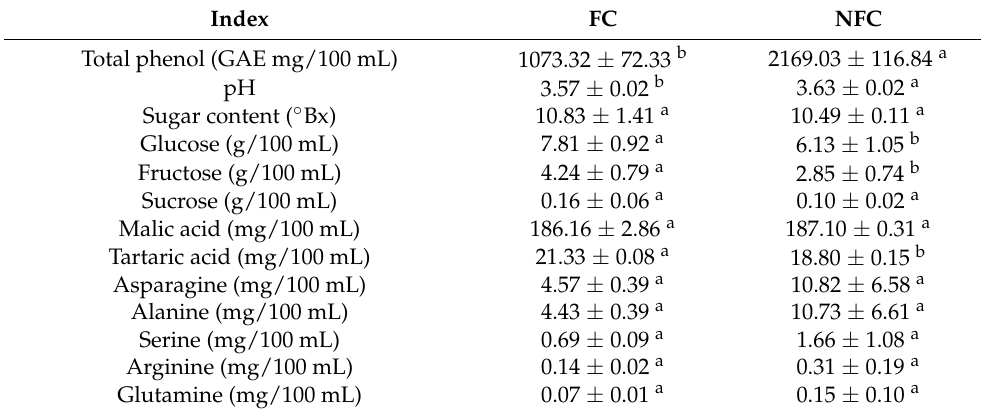
Table 1. Basic indices of NFC and